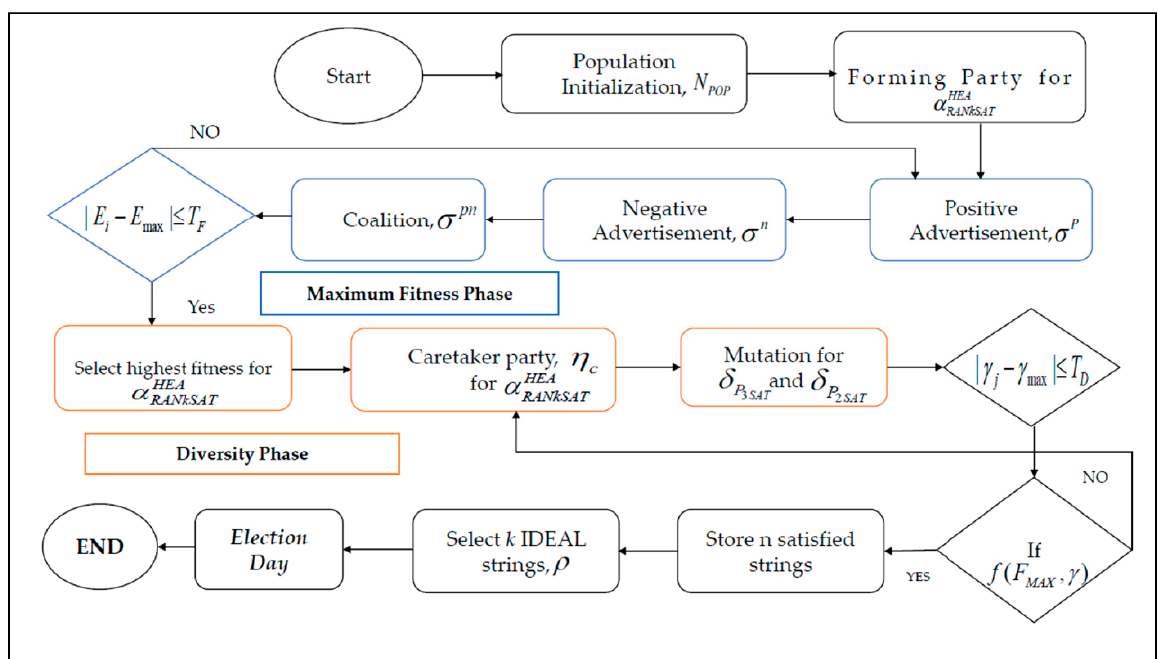
Figure 2. Flowchart of Hybrid Election Algorithm in DHNN-RAN k SAT.